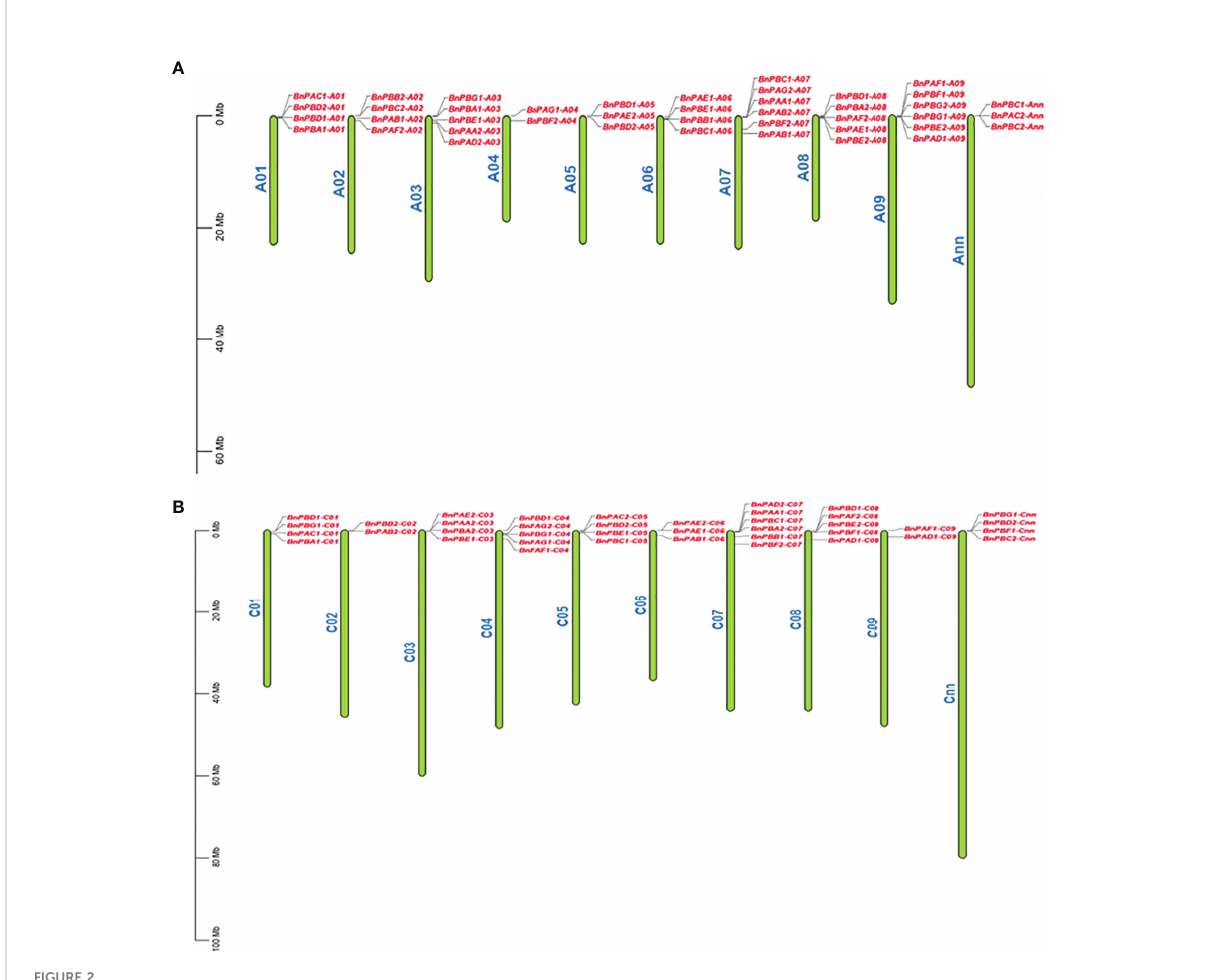
FIGURE 2 Distribution of 82 BnPA and BnPB genes on 20 chromosomes of B. napus belonging to the A (A) and C (B) subgenomes. On each chromosome, gene names are given on the right side. A scale of physical positions in megabases (Mb) is shown on the far